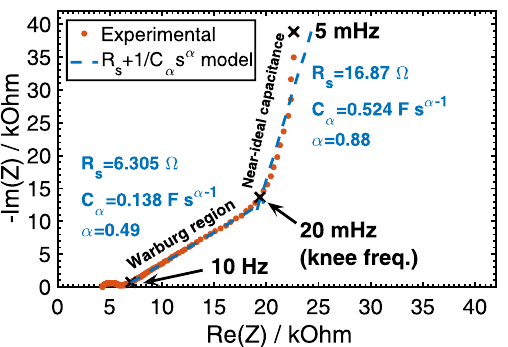
Figure 1. Nyquist plane representation of open-circuit spectral impedance of a NEC/TOKIN supercapacitor (part #FGR0H105ZF, rated 5.5 V, 1 F). Complex nonlinear least-squares fitting to Z ( s ) = R s + 1 / C α s α ( s = j ω ) shows two straight line regions giving the values ( R s ; C α ; α) = ( 6.306 � ; 0.138 Fs α − 1 ; 0.49 ) from 10 Hz to 20 mHz, and ( 16.87 � ; 0.524 Fs α − 1 ; 0.88 ) from 20 mHz to 5 mHz. 20 mHz is a critical frequency separating the near-ideal capacitive behavior from the Warburg